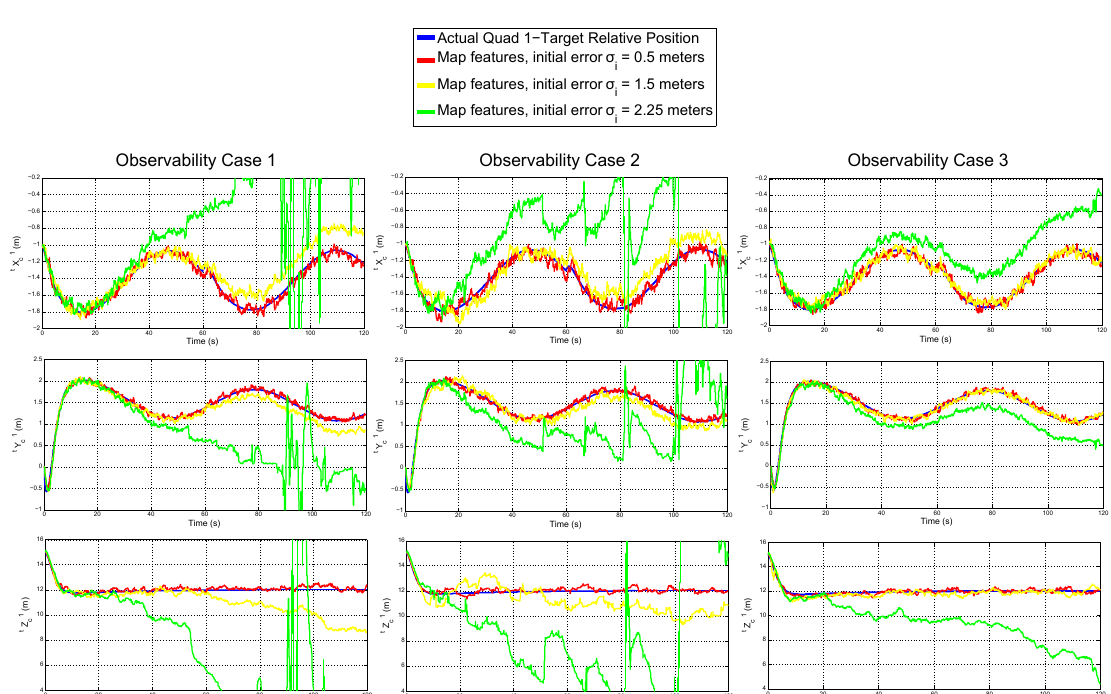
Figure 7. The estimated relative position of the Quad 1 with respect to the target obtained by the Test ( a ).